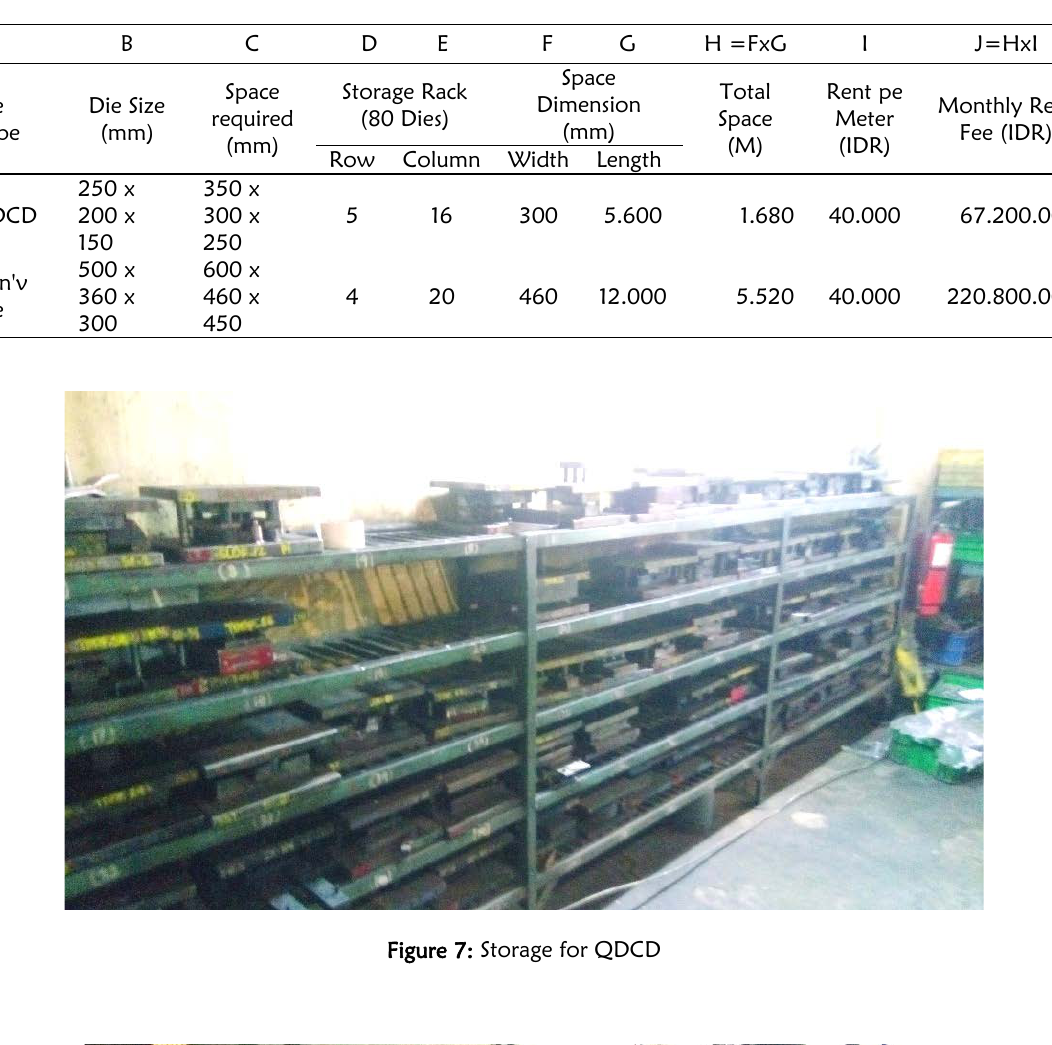
Table 4: Storage comparison for 80 units QDCS and Conventional die